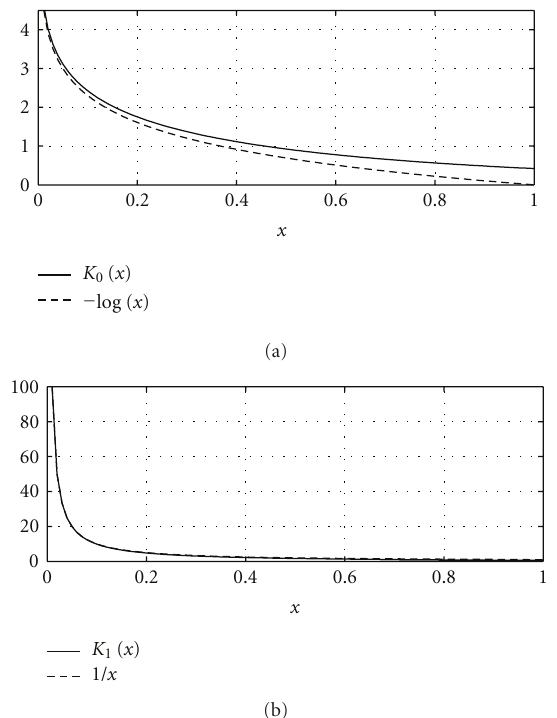
Figure 2: Diagrams of K 0 ( x ) and log(1 /x ) in (a) and K 1 ( x ) and 1 /x in (b), which have the same asymptotic behavior when x →